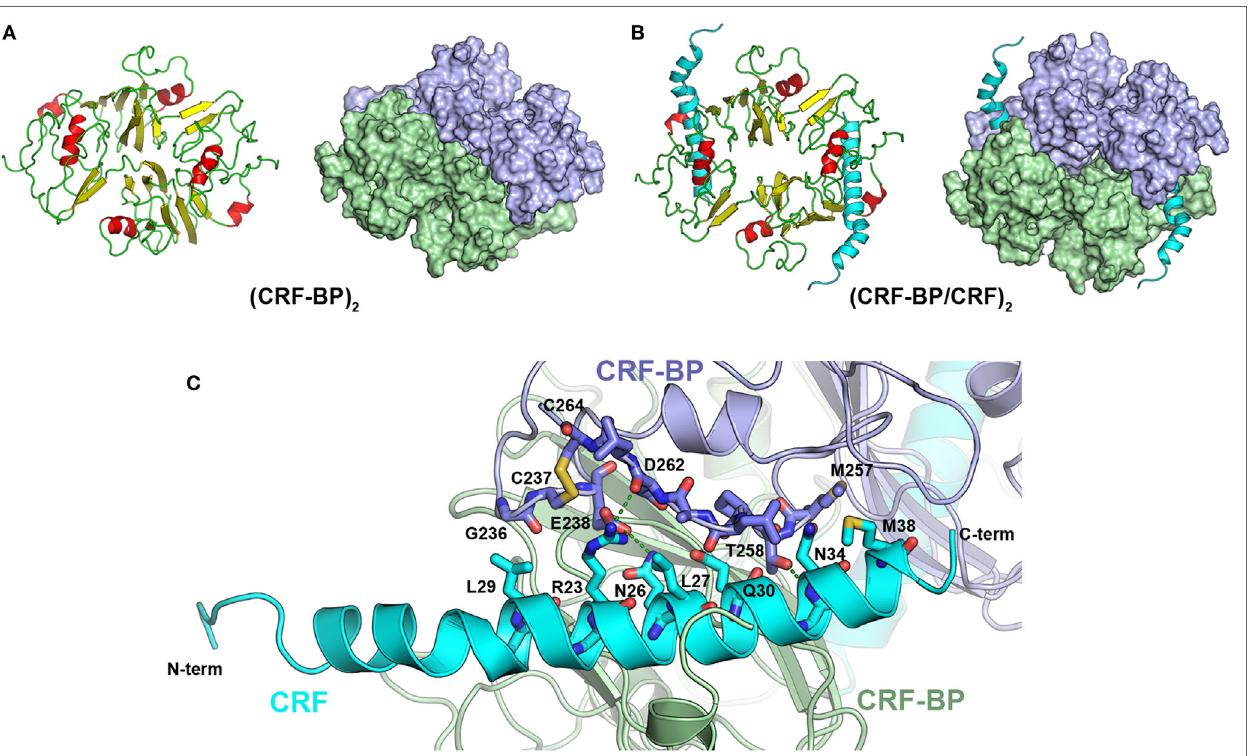
FigUre 3 | Protein–protein docking for CRF-BP homodimer. (a) Modeling of CRF-BP homodimer obtained from the protein–protein docking solution with lowest energy. (B) Modeling of CRF-BP homodimer interacting with two corticotropin-releasing factor (CRF). (c) Schematic representation of CRF-BP/CRF dimerization interaction of CRF and the C-terminal domain of